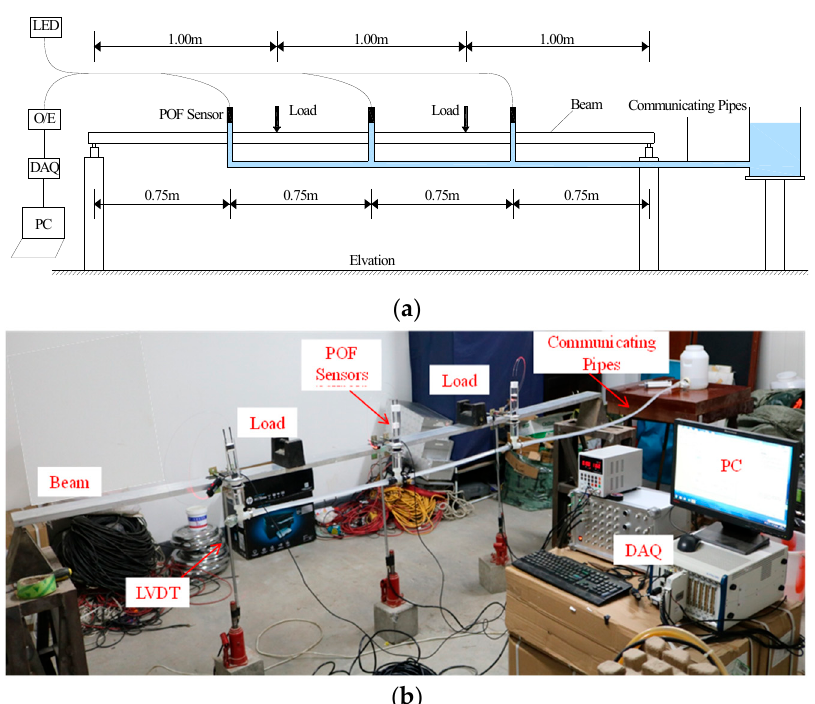
Figure 11. Experimental set-up of the deflection test: ( a ) the scheme for the employment of the POFS-based deflection monitoring system; ( b ) the installed system in the laboratory.